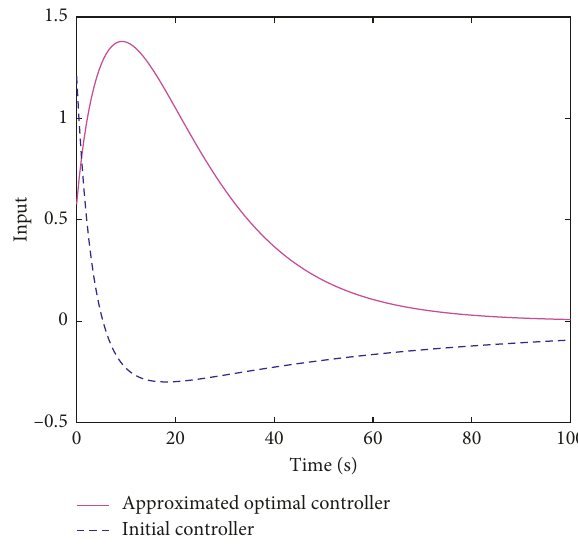
Figure 5: Trajectory of C B driven by initial admissible control and approximated optimal control.